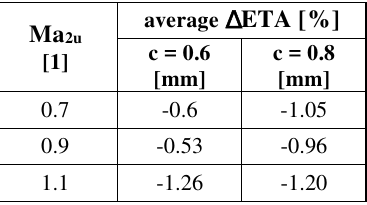
Table 4. Efficiency decrements averaged over compressor flow rates at different rotational speeds